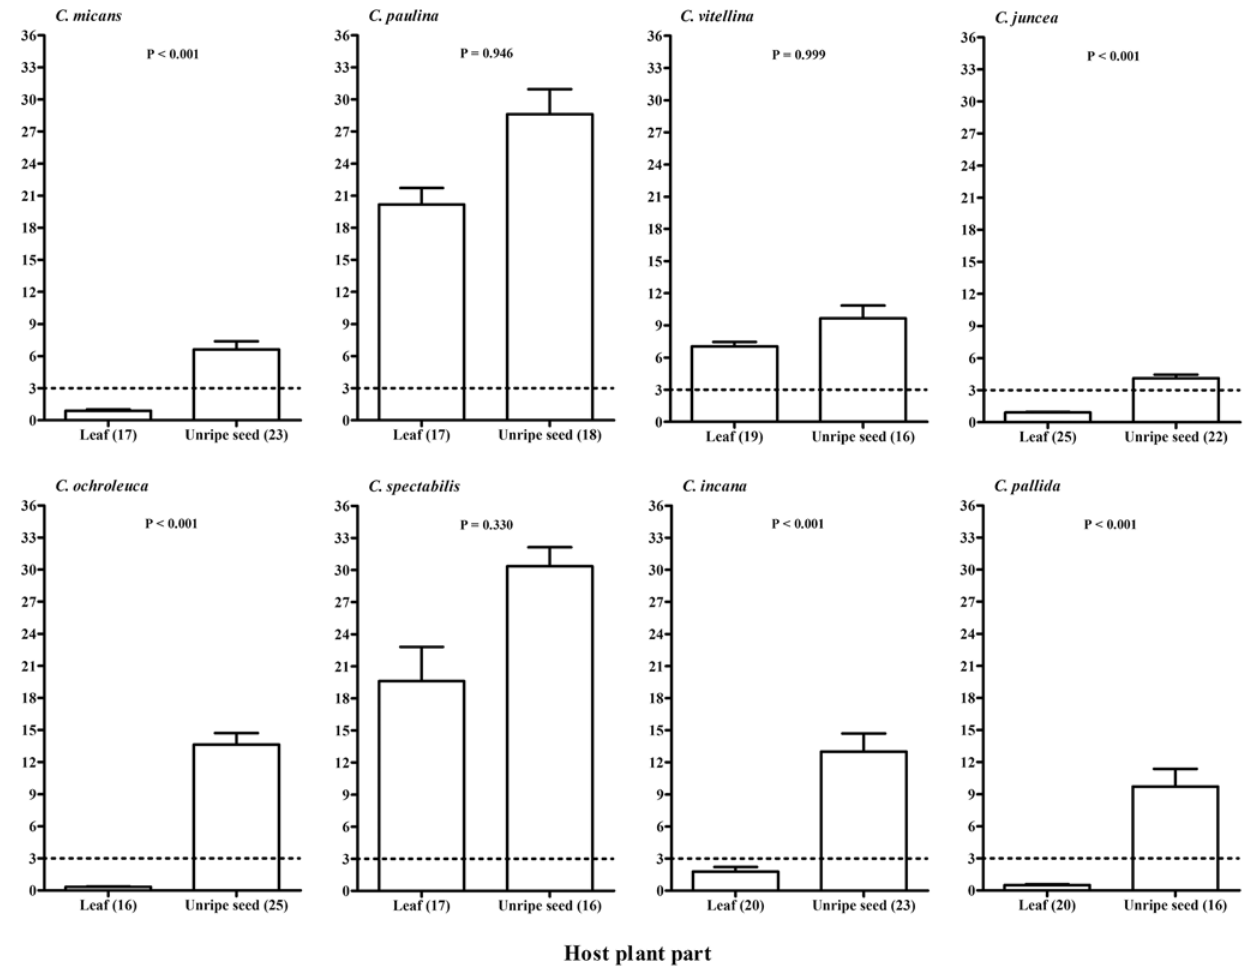
Fig 4. Concentration of pyrrolizidine alkaloids (mean ± se) in adults of Utetheisa ornatrix with respect to eight host-plant species and plant parts (leaves or unripe seeds) fed to the larvae. Numbers in parentheses in "plant part" represent the number of adults analyzed for each diet. The dotted line is the concentration at which baits treated with monocrotaline and integerrimine in the N- oxide form (3.0 μ g/mg) were 100% released by Nephila clavipes . The probability that the PA concentration in adults fed as larvae on leaves or seeds, for each host plant, is significantly different is given above the bars ( post hoc Tukey test). For other statistics, see